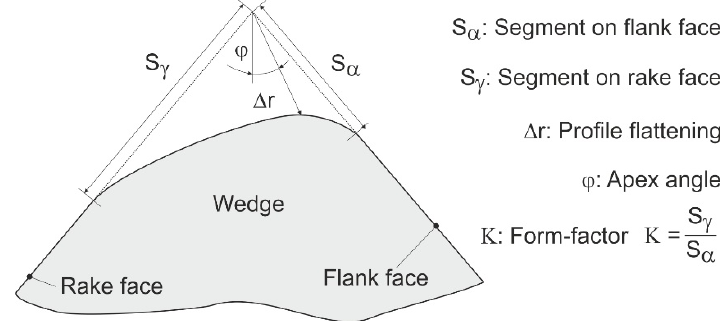
Figure 1. Characterization of the cutting edge microgeometry [2].